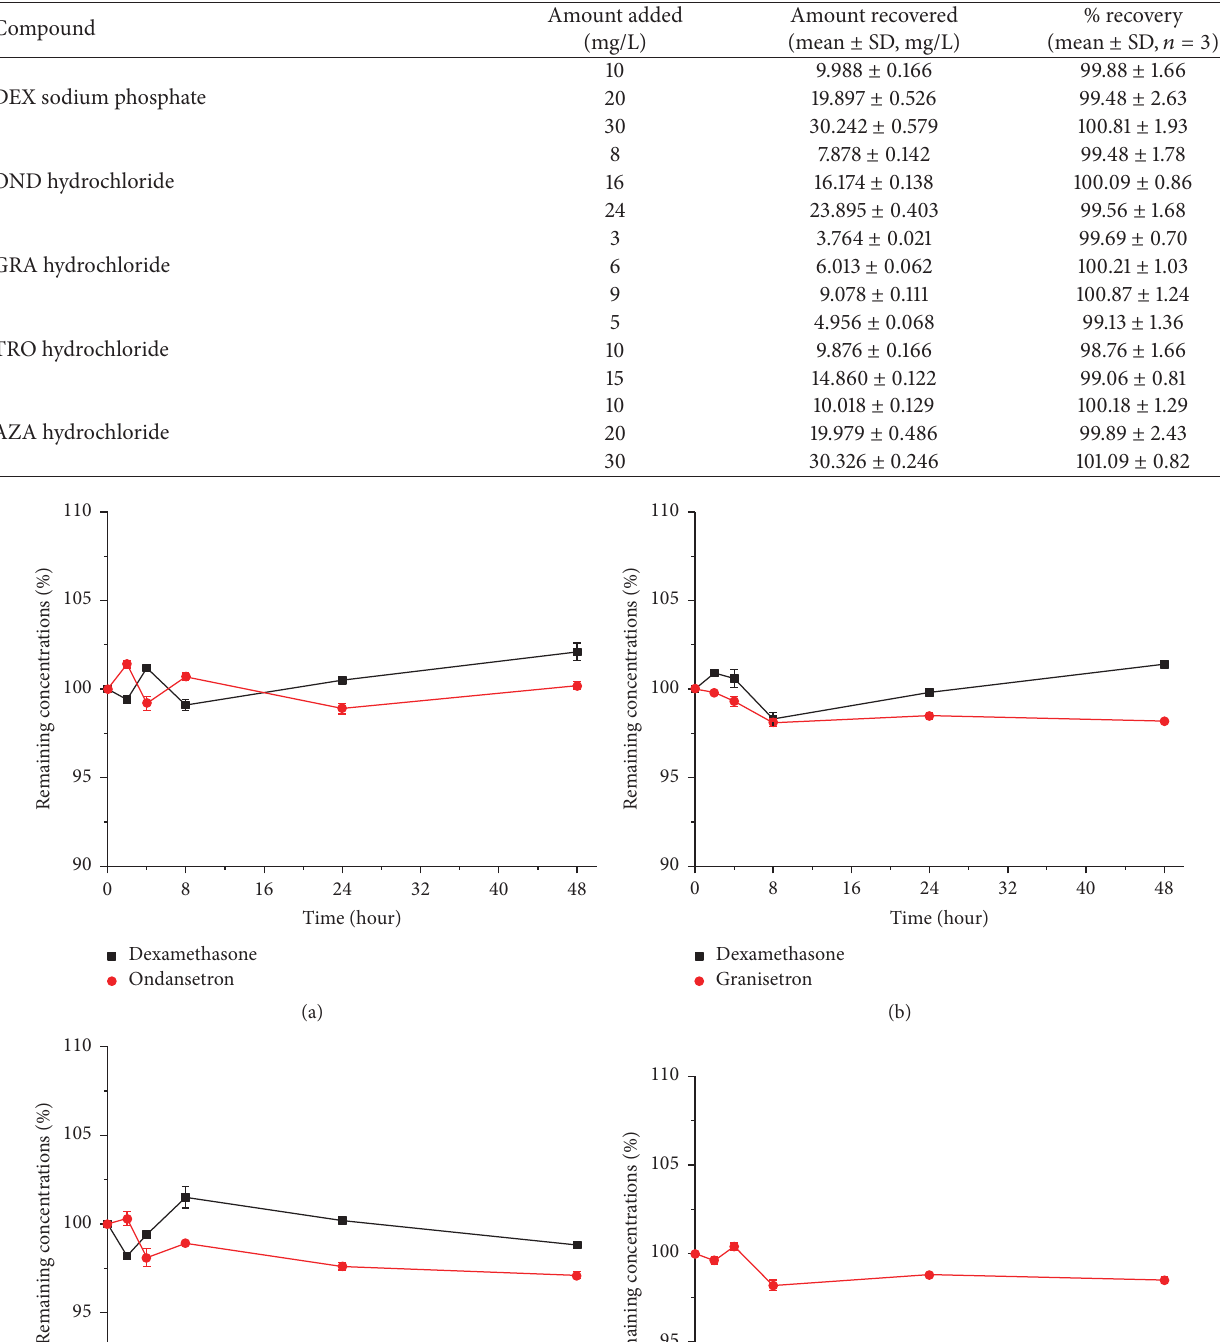
Table 3: Accuracy of the method.